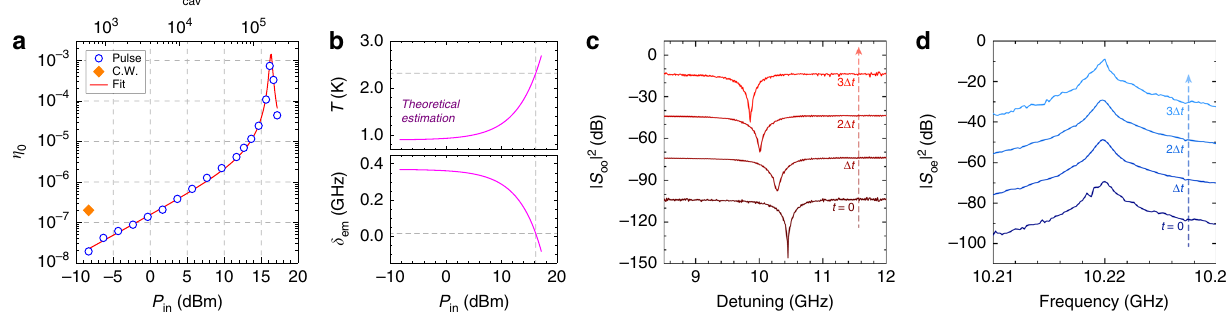
Fig. 4 Conversion ef fi ciency and thermal shift. a Calibrated on-chip microwave-optical photon conversion ef fi ciency η 0 at different optical pump power P in . b Estimated temperature T and electromechanical resonance mismatch δ em of the “ Ouroboros ” at different pump powers. Gray dashed lines label the values at P in = 16 dBm when the highest conversion ef fi ciency is measured. c , d The optical resonance and the conversion spectrum at different time during a 16-dBm pump pulse, respectively. The spectra are vertically displaced for comparison purpose. The time resolution is Δ t ≈ 1.17 μ